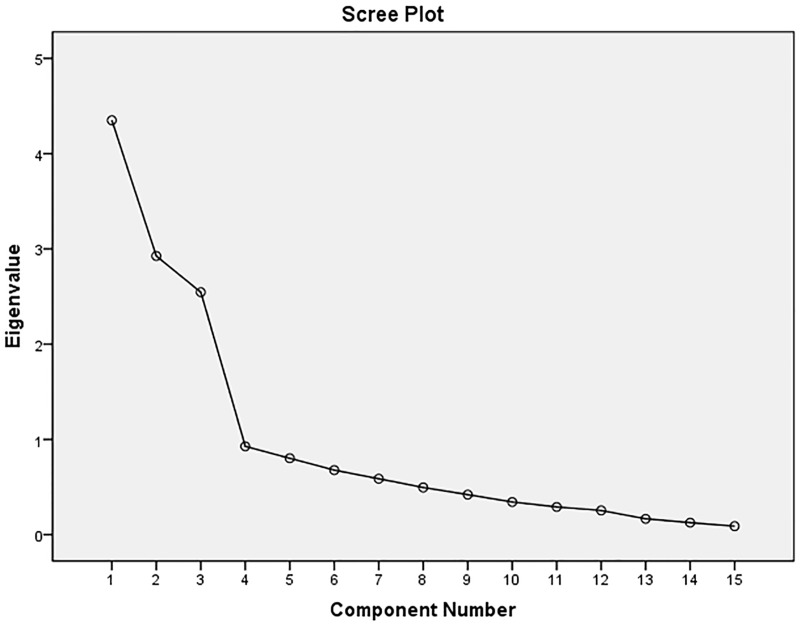
Scree Plot of ASAS-R-CHI (n = 576).Note. ASAS-R -CHI: the Chinese version of the revised form of the Appraisal of Self-care Agency Scale.